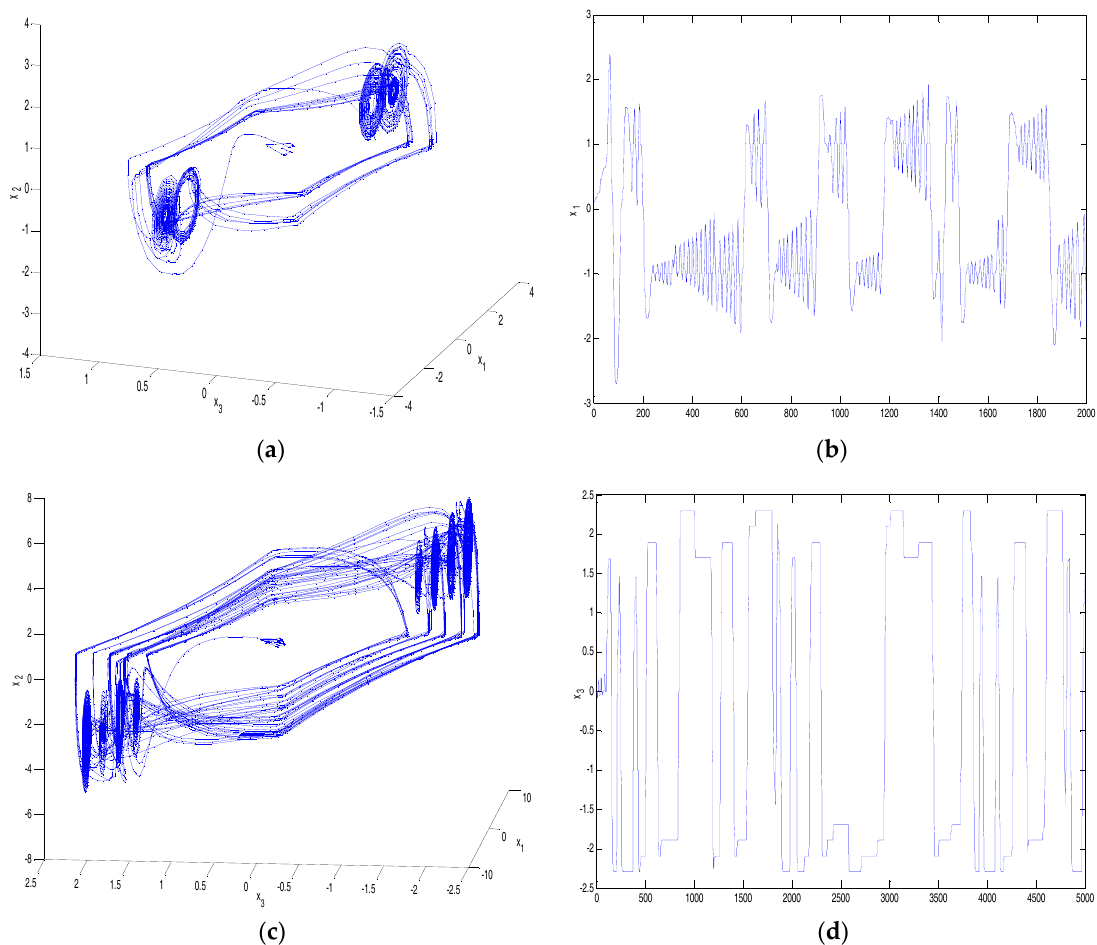
Figure 10. Numerical results of the 3 ‐ D multi ‐ scroll attractors ‐ I: ( a ) 2 ‐ double scrollin x 1 ‐ x 2 ‐ x 3 plane; ( b ) variable x 1 (t); ( c ) 4 ‐ double scrollin x 1 ‐ x 2 ‐ x 3 plane; and ( d ) variable x 3 (t). 4.3.2. 3 ‐ D Multi ‐ Scroll Attractors along x 3 ‐ x 2 ‐ x 1 Directions: